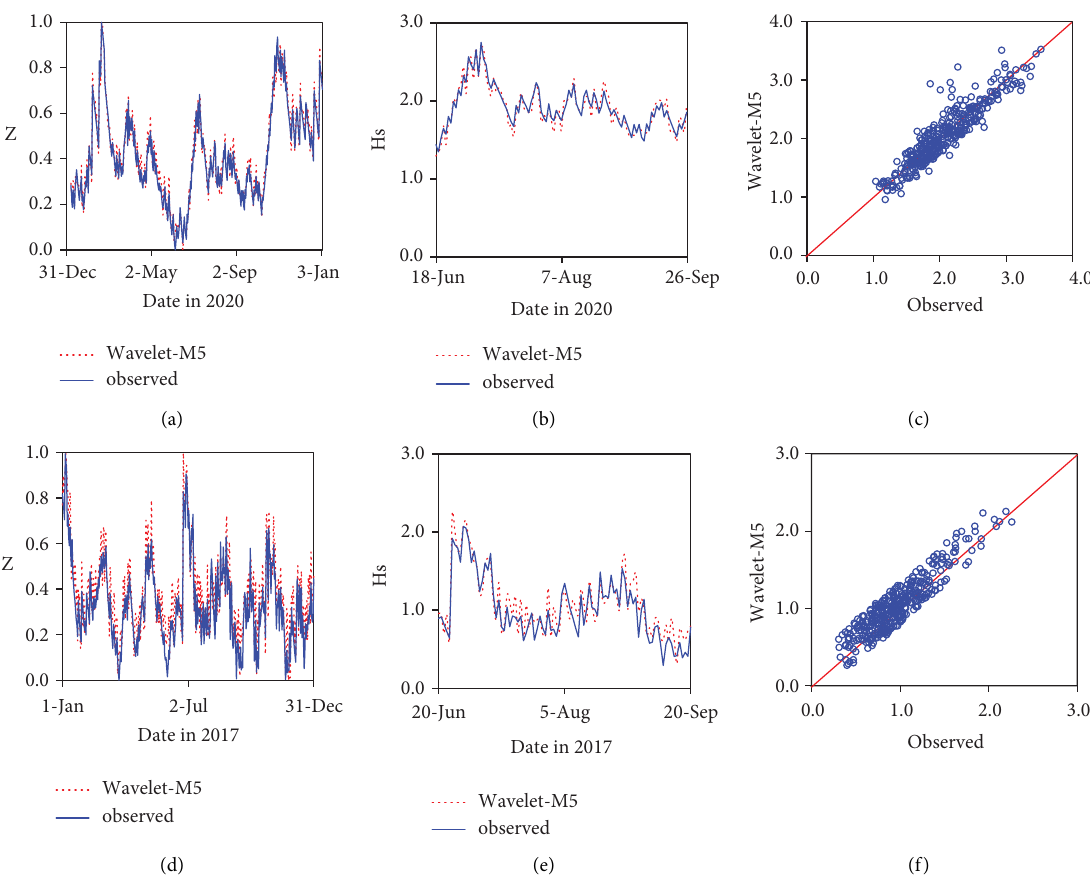
Figure 8: Times series of test and train normalized signifcant wave height and the corresponding scatter diagram by the wavelet- M5 model (a–c) in the Hambantota Port (2020) and (d–f) in the Sanmen Bay